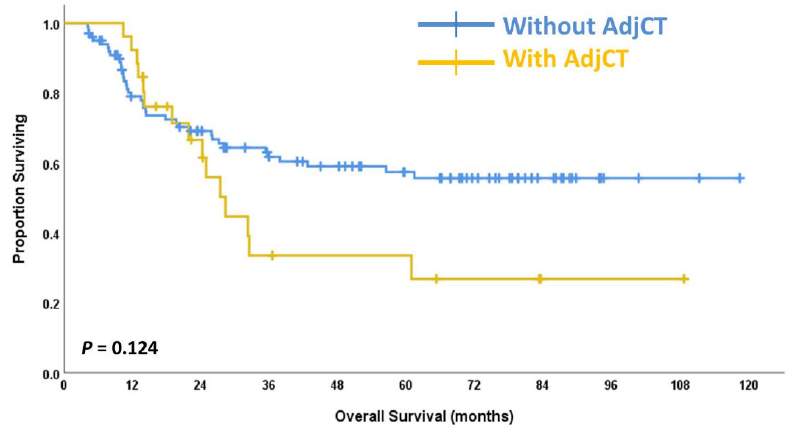
Figure 2. The overall survival curves for the group of patients receiving adjuvant chemotherapy (AdjCT) and the group without adjuvant chemotherapy (AdjCT).